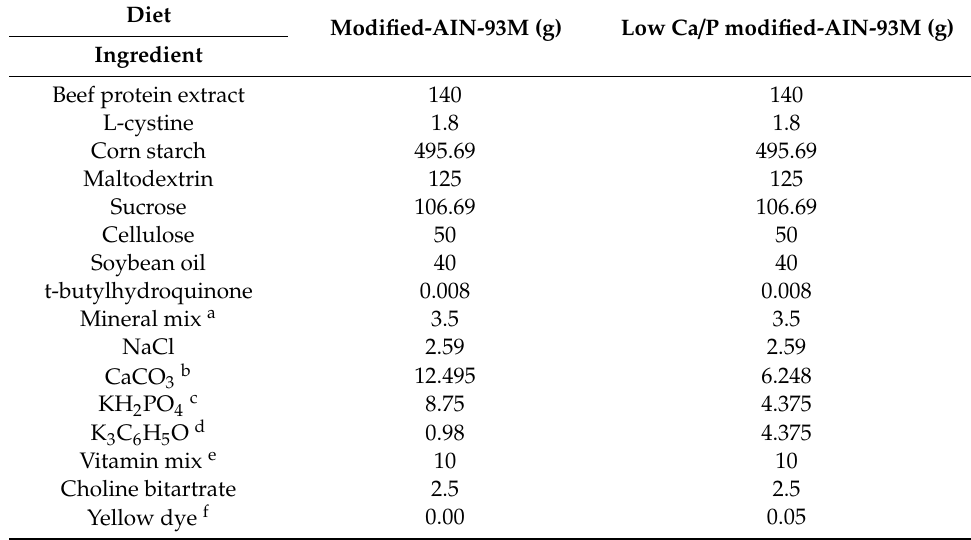
Table 1. Composition of the modified-AIN-93M and low Ca / P modified-AIN-93M diets used in the animal feeding trial *